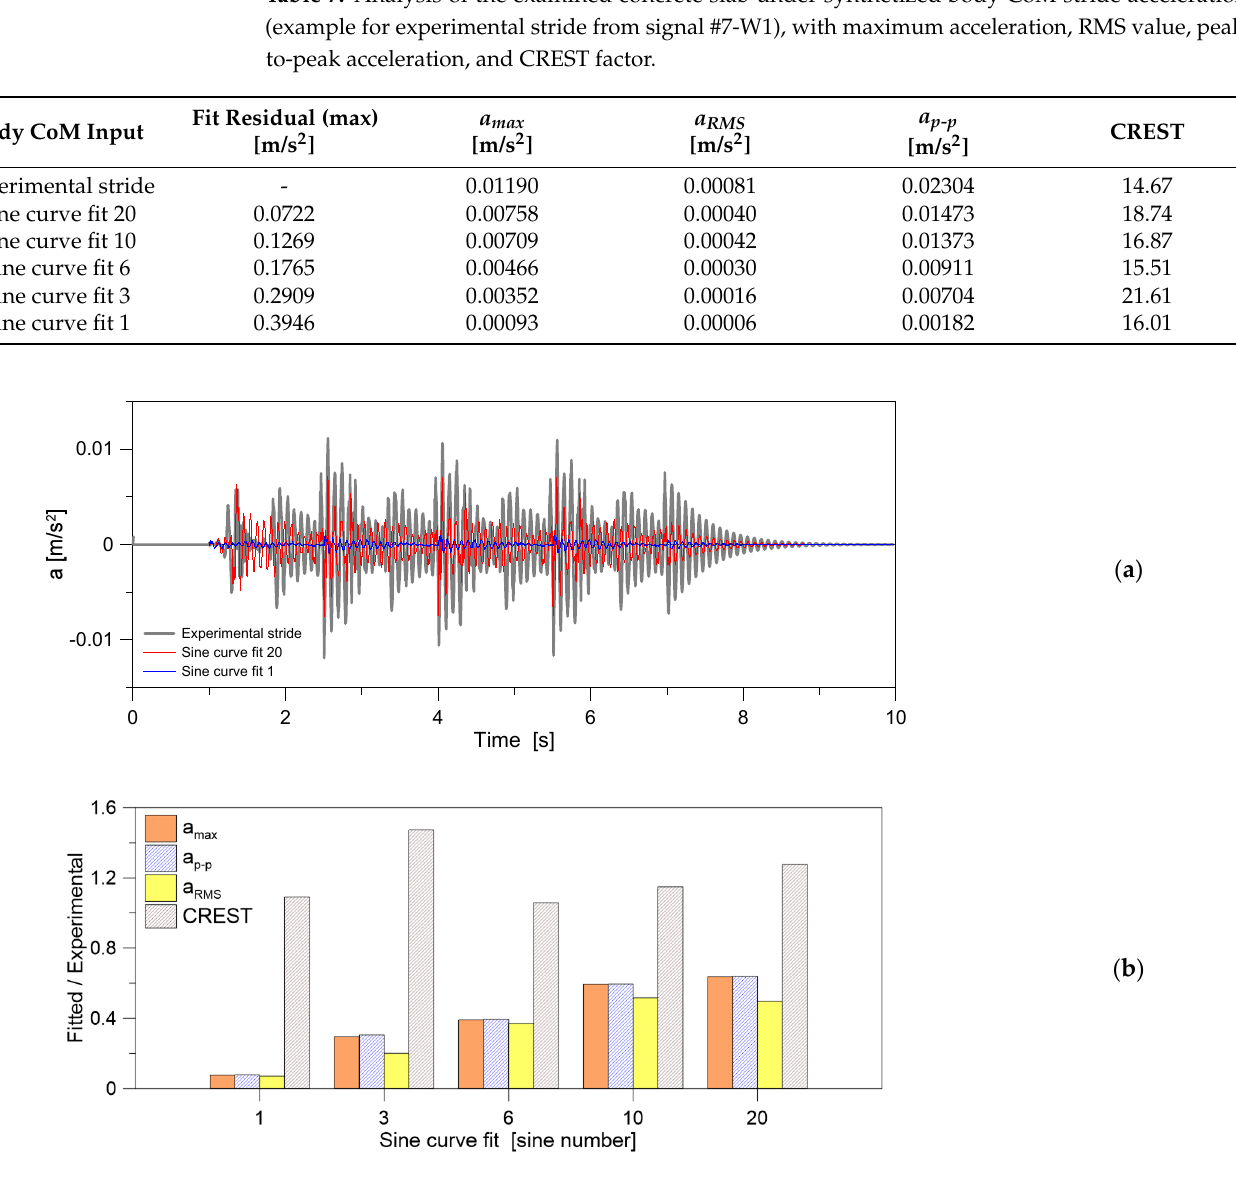
Figure 20. Numerical response of the examined concrete slab under experimental body CoM accelerations—synthetized stride signal #7-W1 (ABAQUS): ( a ) acceleration at the center of slab, and ( b ) normalized performance indicators based on the fitted stride signal.